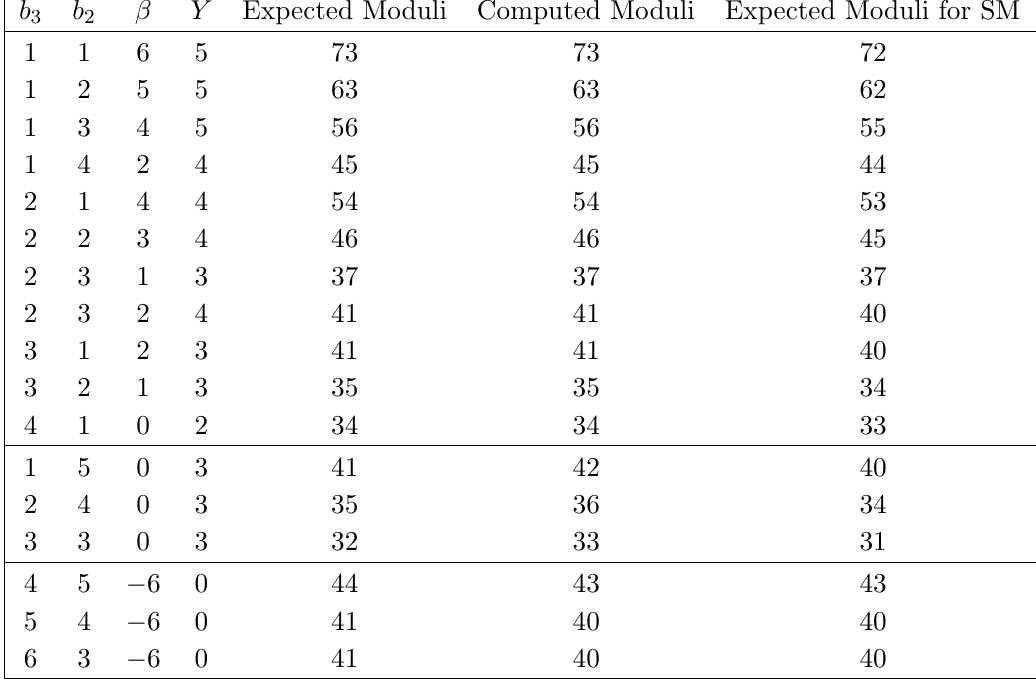
Table 6 . Moduli counting for models with ine(cid:11)ective [ d 2 ]. The column labeled \Expected Moduli" gives the number of moduli for the su (3) (cid:8) su (2) (cid:8) u (1) (cid:8) u (1) model that are expected from 6D anomaly cancellation, given the global gauge group structure consistent with the spectrum in table 5. The column labeled \Computed Moduli" gives the number of moduli calculated from the rank of the Jacobian matrix (7.2). The column labeled \Expected Moduli for SM" gives the number of moduli that would be expected for the su (3) (cid:8) su (2) (cid:8) u (1) model based on 6D anomaly